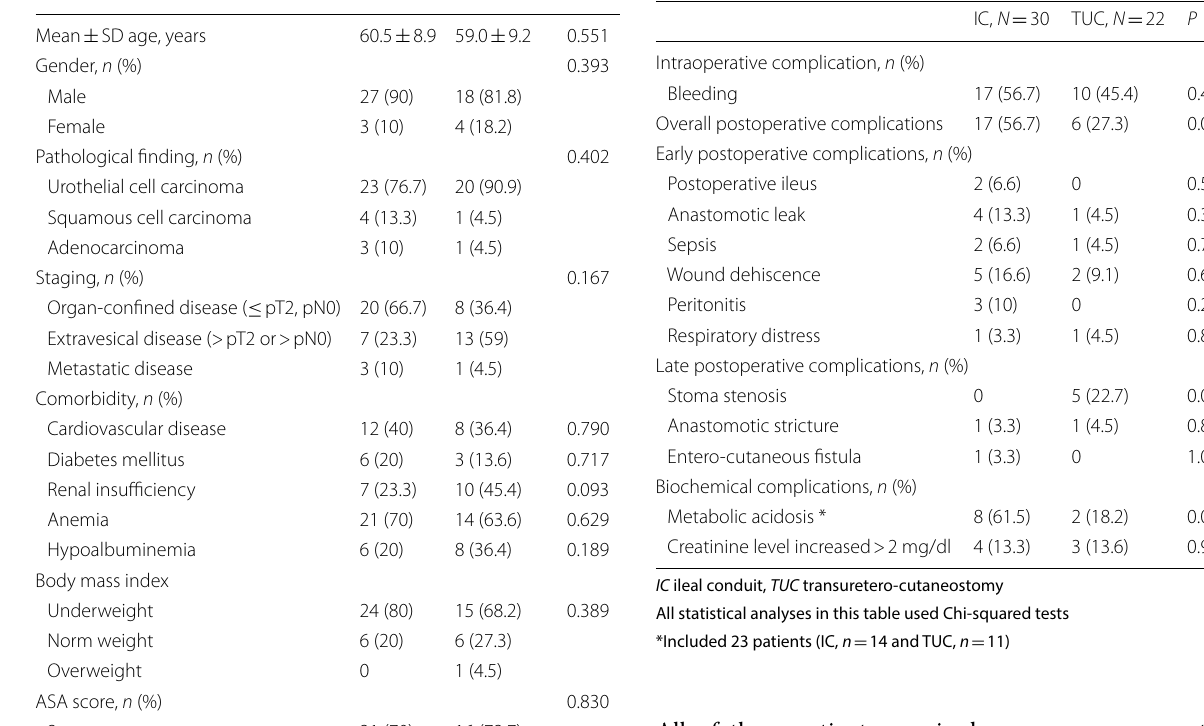
Table 1 Clinical characteristics of the study population